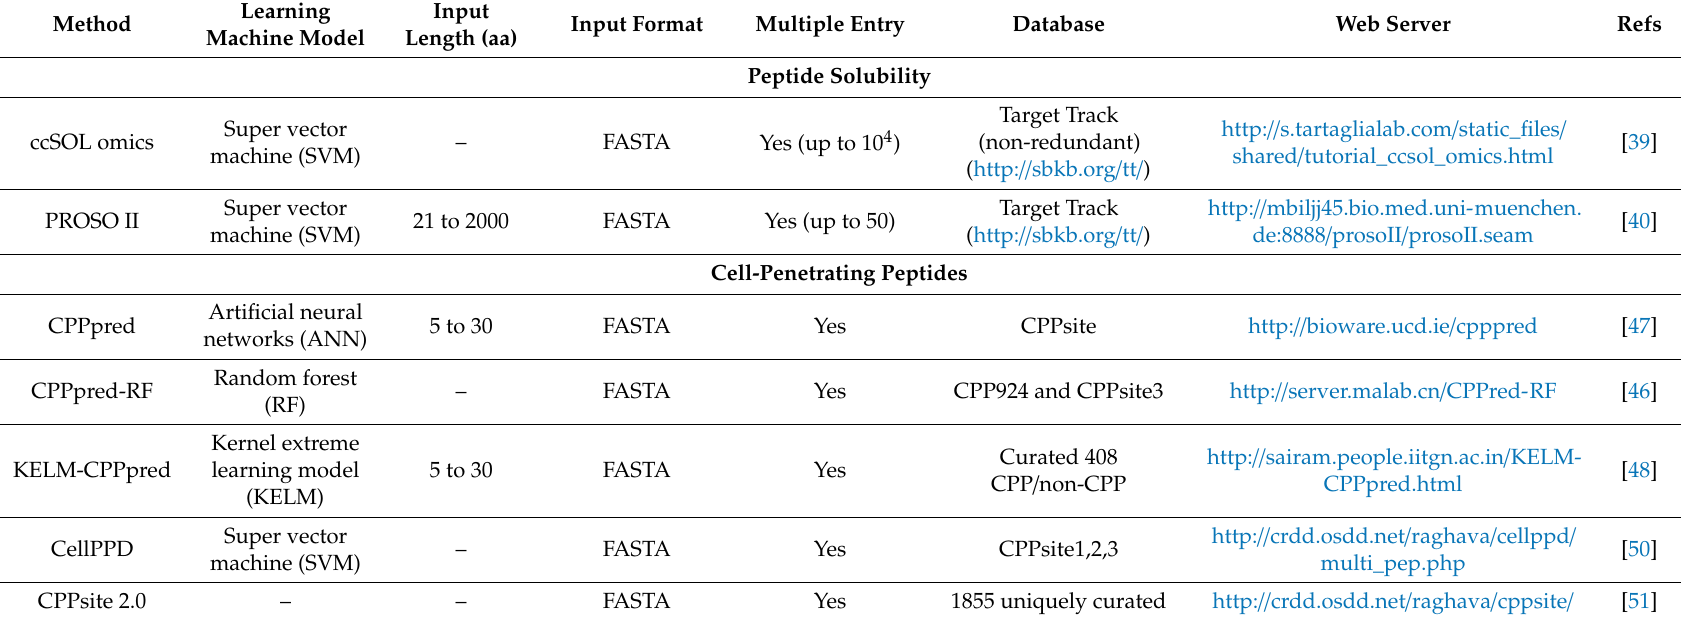
Table 1. Overview of prediction methods for peptide solubility and cell-penetrating